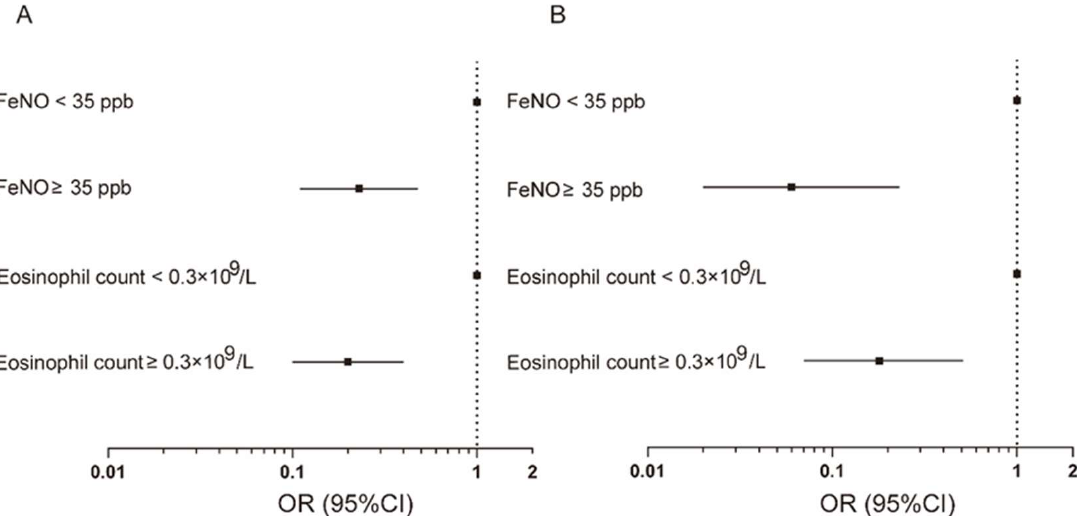
Figure 2. Separate association of increased FeNO level and blood eosinophil count with incidence of acute exacerbation of COPD: ( A ) Smoking status adjusted; ( B ) multivariable adjusted. Logistic regression models were used. Multivariable adjustment included age, gender, BMI, smoking status, FEV 1 post-BD% pred, SGRQ, 6-minute walking distance. FeNO, exhaled nitric oxide fraction; BMI, body mass index; FEV 1 , forced expiratory volume in 1 s; BD, bronchodilator; SGRQ, St. George’s Respiratory questionnaire.